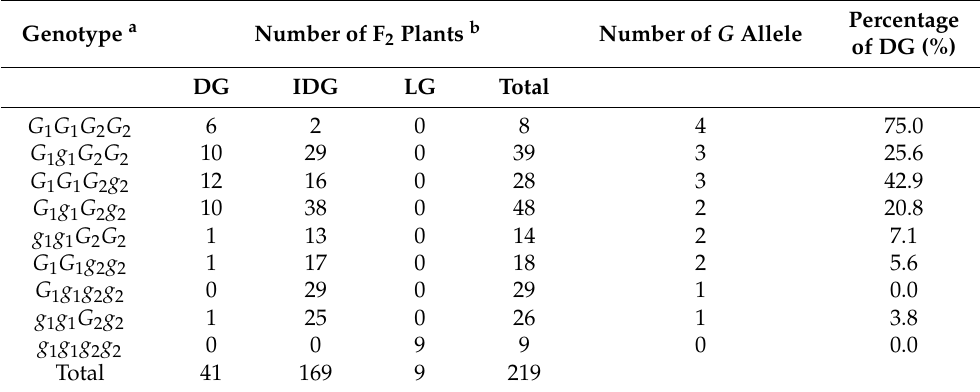
Table 3. Phenotypic distribution of F 2 plants based on the CAPS marker genotypes for two loci G 1 and G 2 controlling the rind color of watermelon fruits. Genotype a Number of F 2 Plants b Number of G Allele